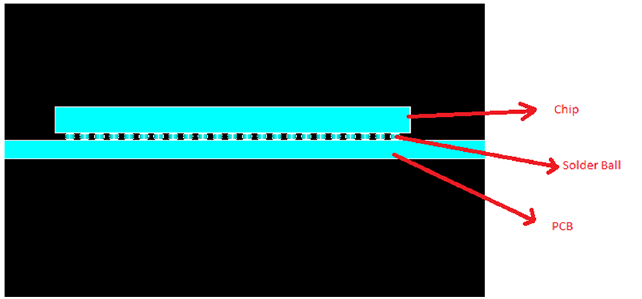
Fig. 6. Finite element model.